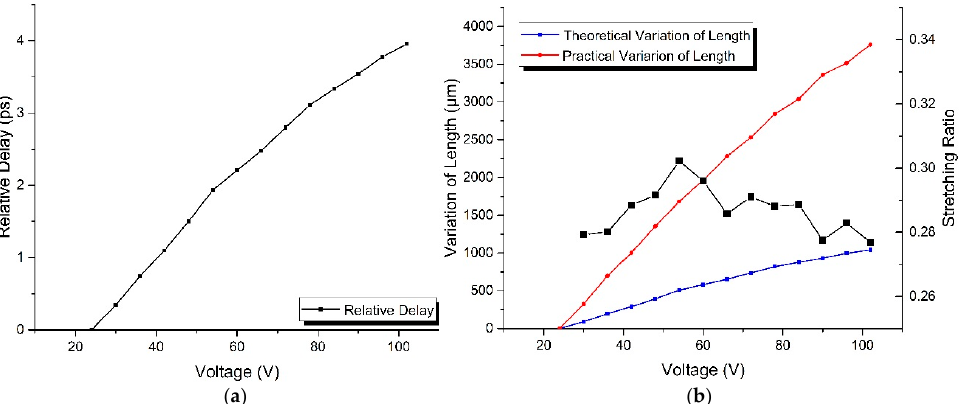
Figure 7. The calibration of strain in the voltage range of 102–24 V with a decrement step of 6 V: ( a ) The response of relative delay to voltage; ( b ) The response of variation of length to voltage.